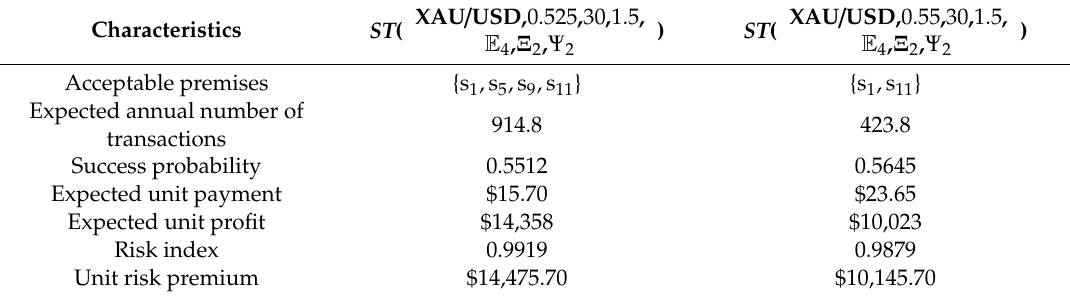
Table 7. Juxtaposition of local characteristics of ST systems applied for XAU/USD market.